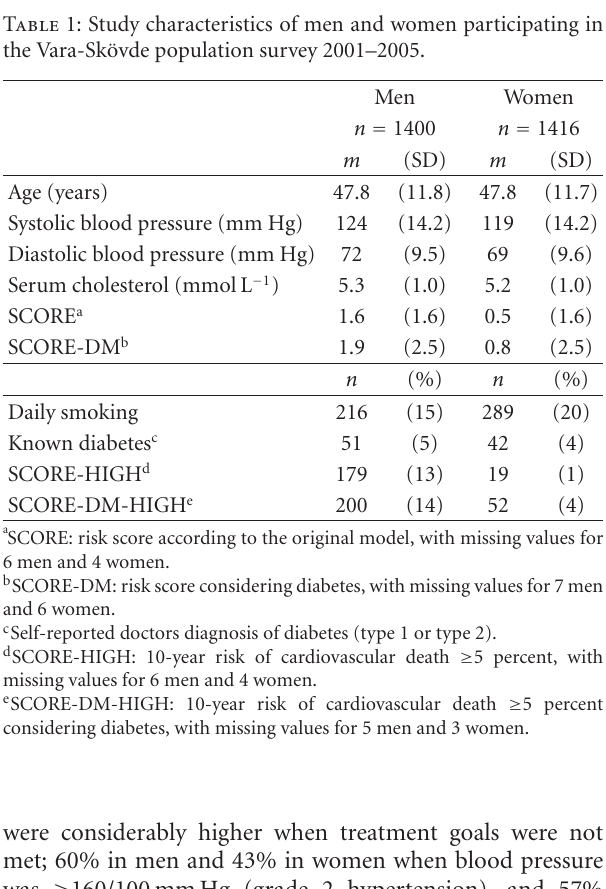
Table 1: Study characteristics of men and women participating in the Vara-Sk¨ovde population survey 2001–2005.